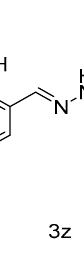
Table 2. The EC 50 value of some title compounds.